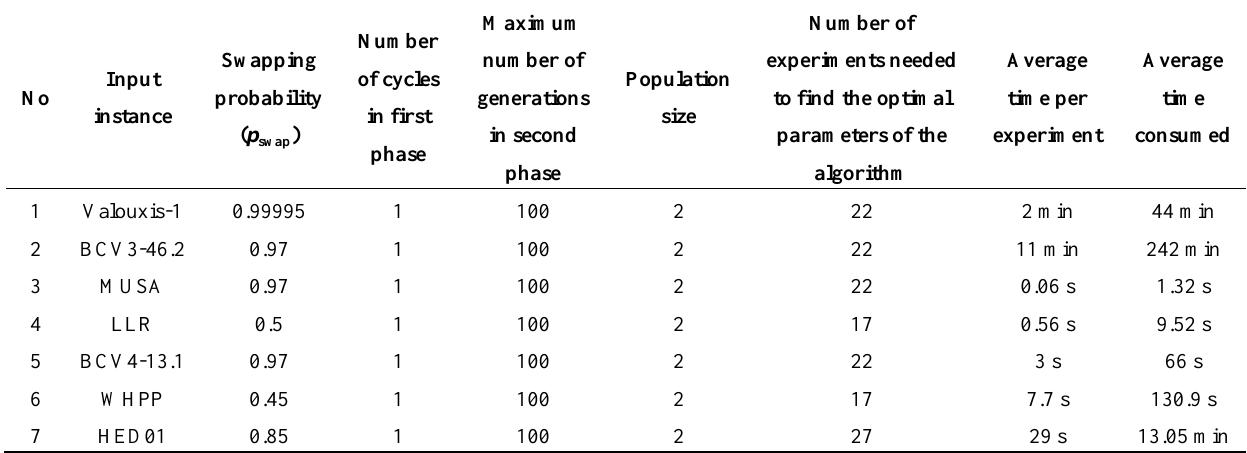
Table 1. The parameters’ values used for each input